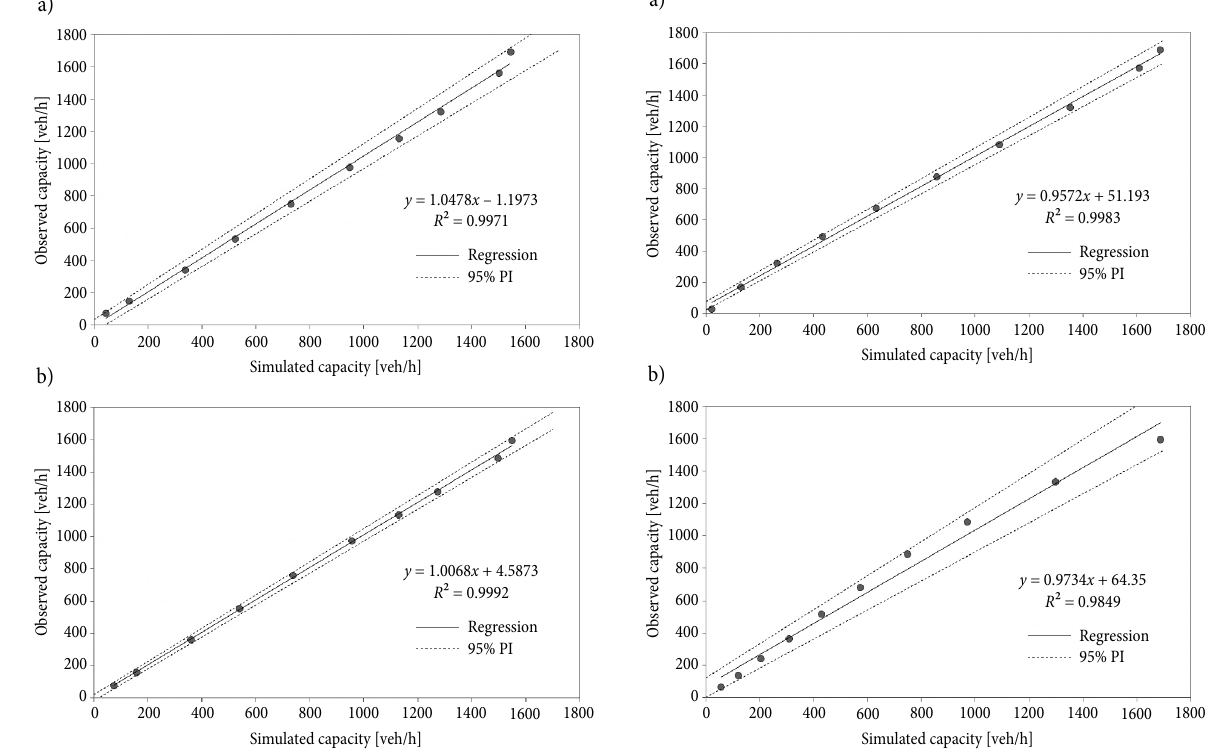
Fig. 4. Observed versus simulated capacities at minor entries: a – the right-lane; b –